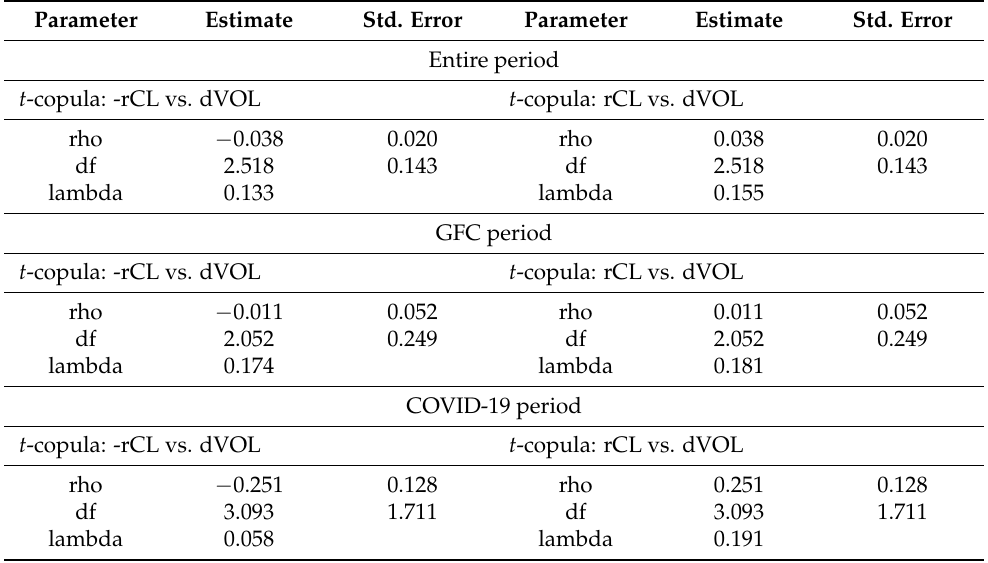
Table 3. Copula parameters and tail dependence coefficient for Crude Oil Future Contract returns (rCL) and changes in the volatility of Crude Oil Future Contract returns (dVOL) in the entire period and sub-periods.